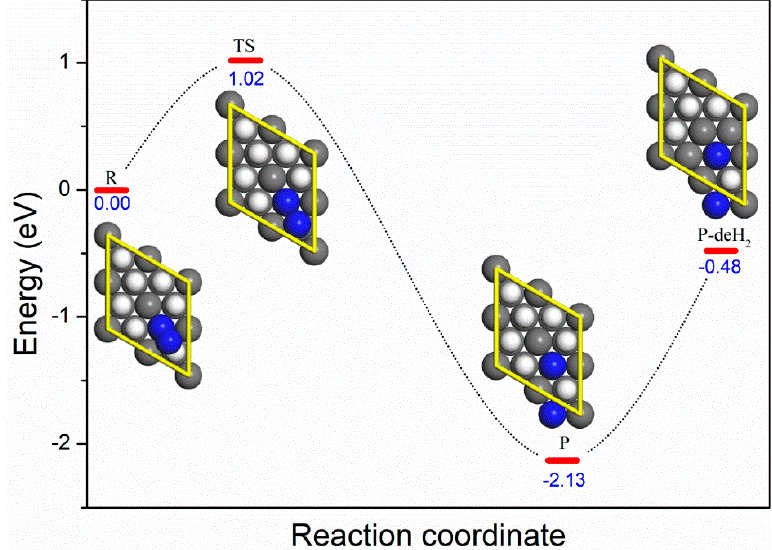
Figure 6. The potential energy profile of the nitrogen dissociation. The preferential adsorption of molecular nitrogen with the ccp site and Ori1 orientation was chosen as the starting point R, and the ccp-ccp was the product P. P-deH 2 represents the dehydrogenation product.